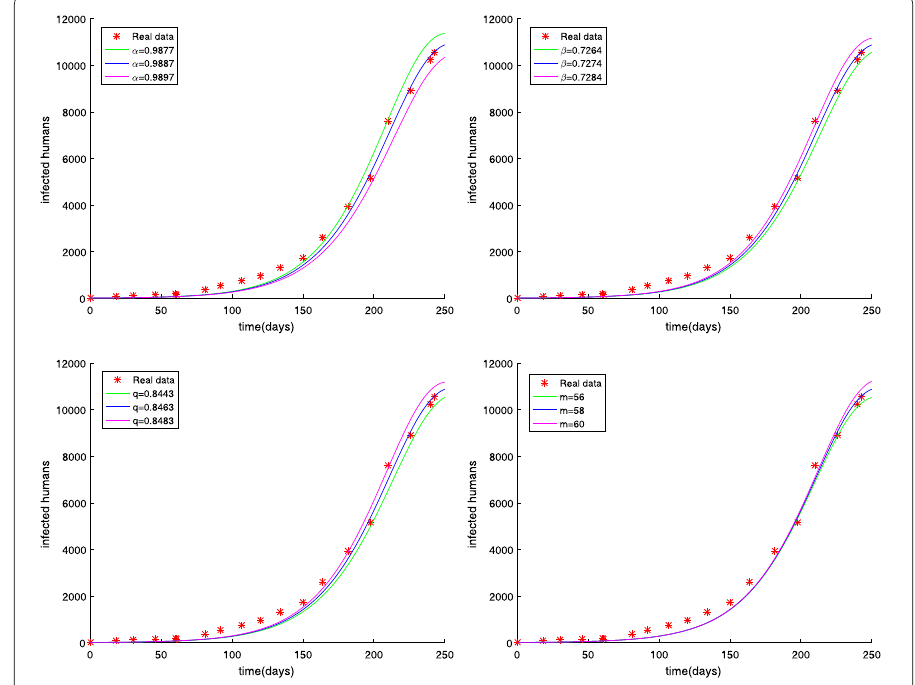
Figure 4 The influence of α , β , q , m on the number of Ebola infections I ( t ), when the remaining parameters are fixed